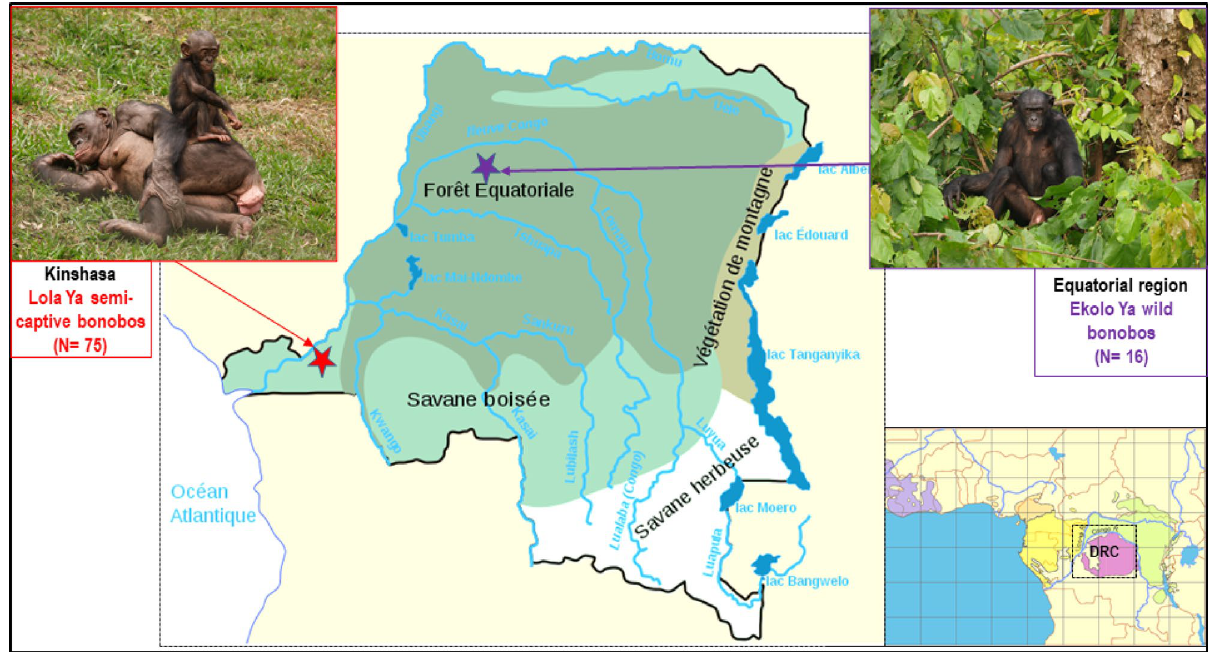
Figure 8. Study area. Samples from Lola Ya Bonobo (n = 75) where animals live in a sanctuary dedicated to the rehabilitation of orphan bonobos near Kinshasa, they are in permanent contact with humans. Samples from site Ekolo Ya bonobo (n = 16) were collected in nature where bonobos were introduced into the wild in the equatorial region. Figure modified from: https:// docpl ayer. fr/ 16290 5495- Repub lique- democ ratiq ue- du- congo- minis tere- de-l- envir onnem ent- et- devel oppem ent- durab le.